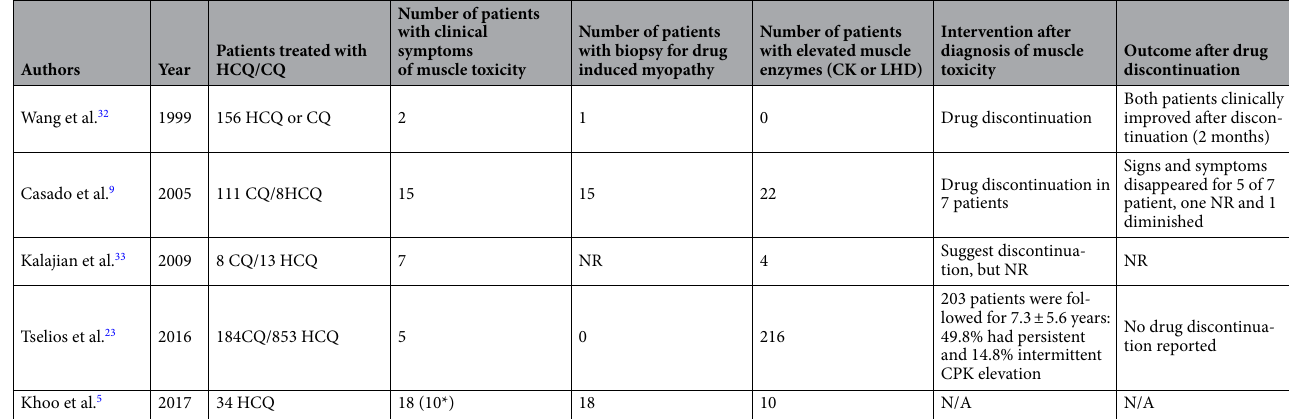
Table 2. Qualitative data for the six studies selected for CQ/HCQ-induced myopathy. In Casado et al. 9 , 22 patients were reported with elevated muscle enzymes, but only 15 patients are present with complete follow-up information for clinical symptoms. Regarding the study of Tselios et al. 23 , the number of patients treated with HCQ or CQ were extracted from a total of 1,037 patients. Symbol (*) indicate patients presenting muscle weakness and without histological features/markers positive for active inflammatory myositis (primary